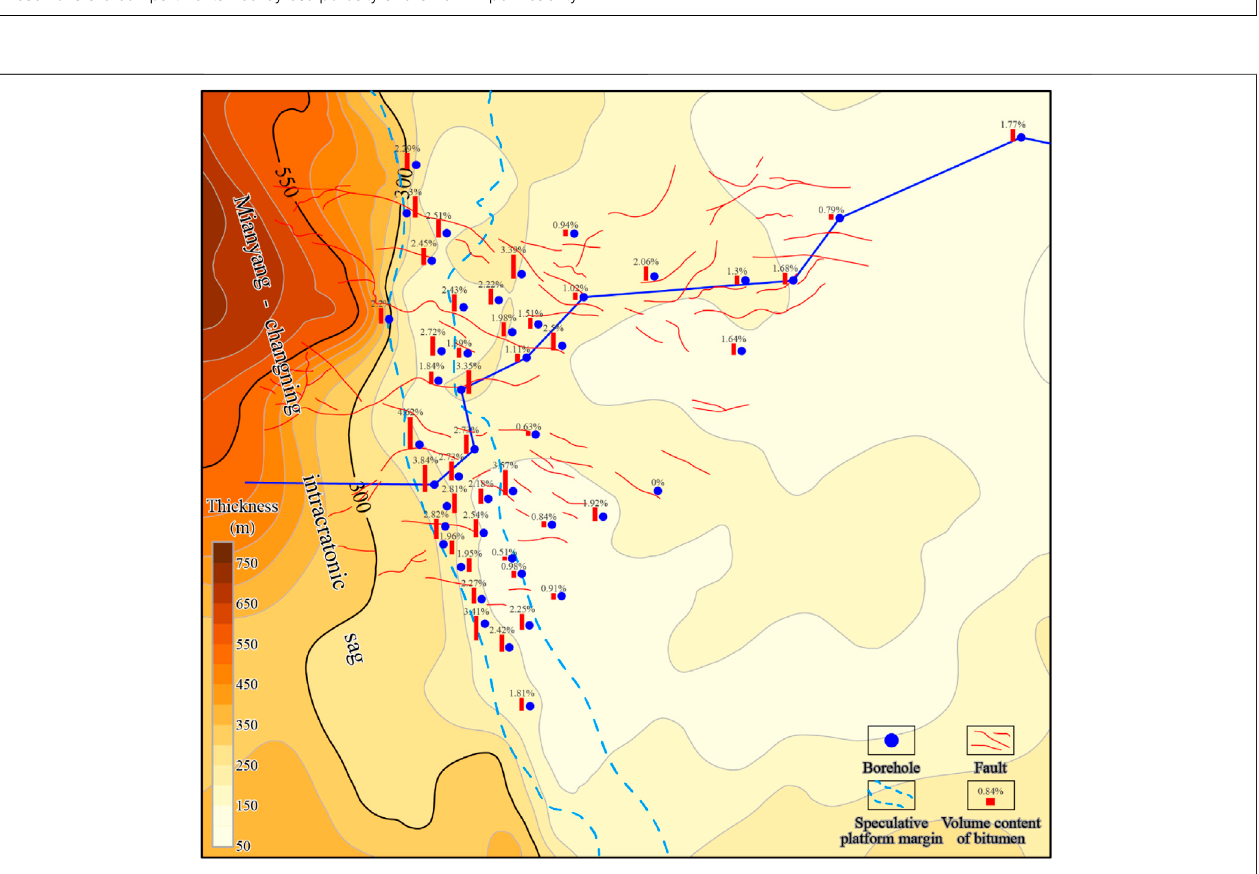
FIGURE 11 | Combined source rock thickness of the lower Cambrian Є 1 m and Є 1 q. Single-borewell volume content of solid bitumen and faults, of the Z 2 dn 4 , are added to the thickness map. The volume contents of bitumen in the boreholes within the speculative platform margin intuitively exceed those in the intraplatform region. The fault system plays an important role in lateral hydrocarbon migration. The volume content of solid bitumen is cited from Song et al. (2021).